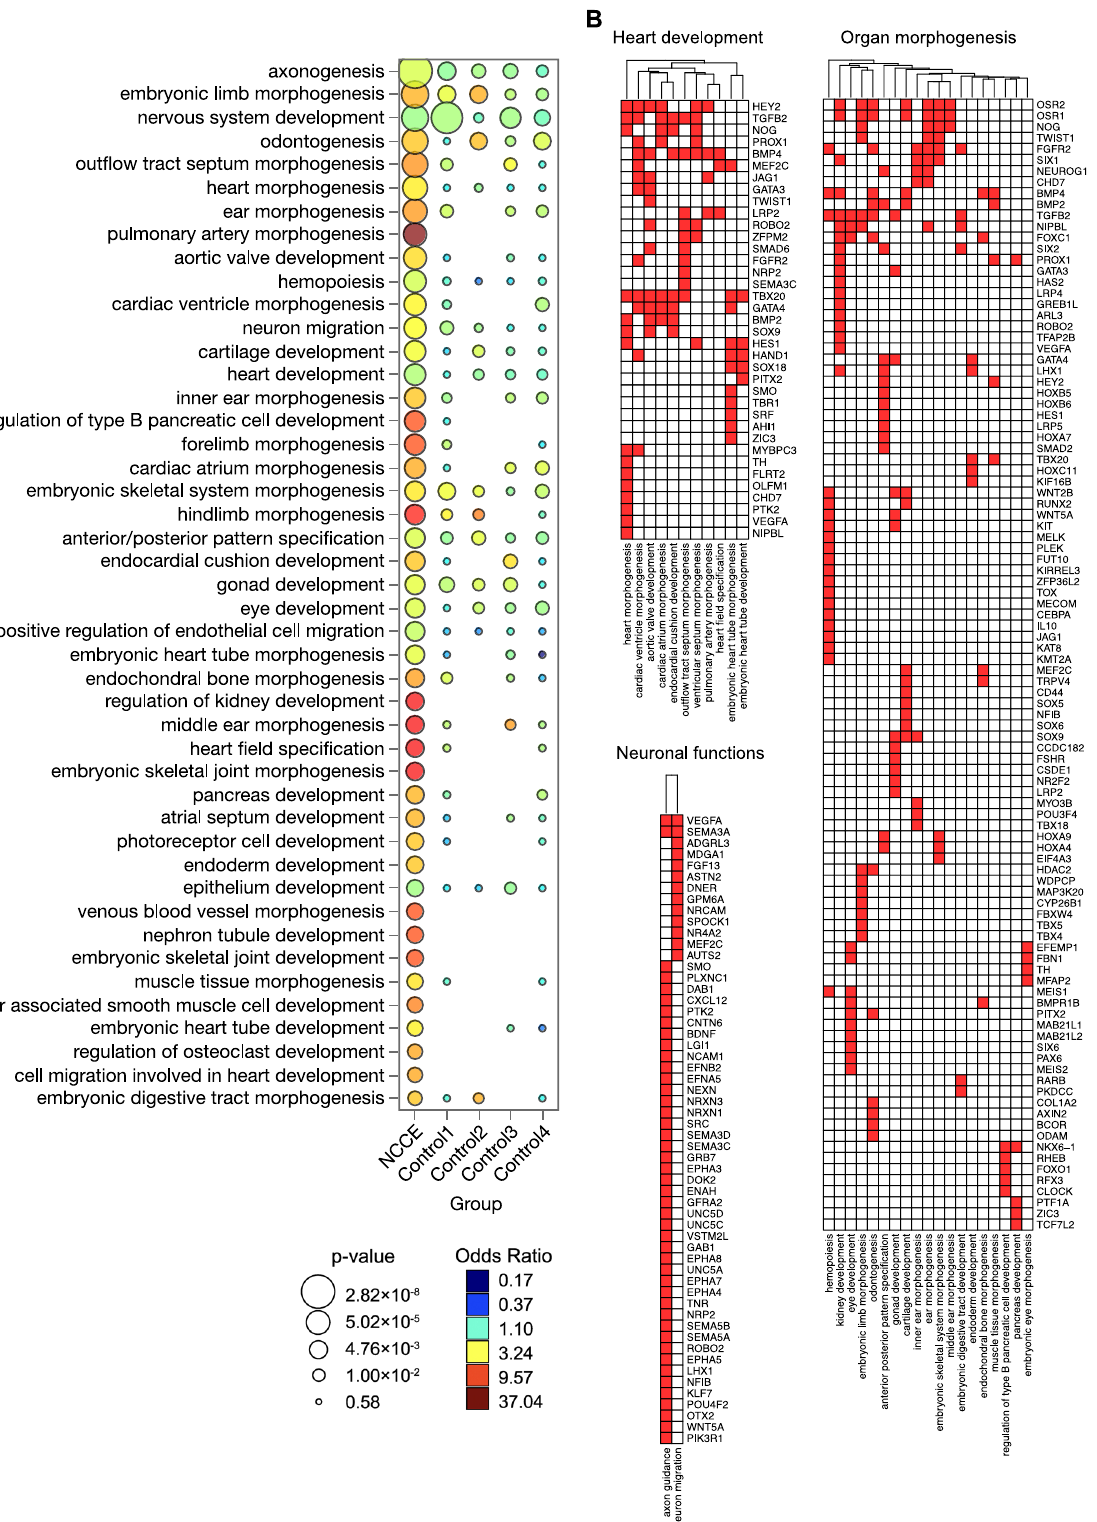
Fig. 5 | Genome-wide NCCE are associated with organ morphogenesis. A Select GO terms enriched in NCCE+genes compared to controls. NCCE+genes are de fi ned as genes nearest to conserved NCCE, where the NCCE are de fi ned as having a 6 – 16bp spacing between the centers of a COUP-TFII and an NKX HD motif. Control 1: genes associated with conserved COUP-TFII and NKX HD